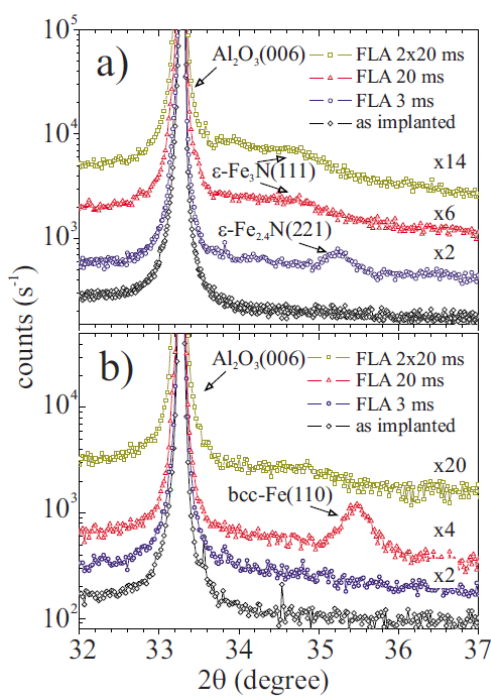
Figure 6. In-situ SXRD (SXRD) observation of the formation of nanoclusters in Fe-implanted p -GaN with a dose of: ( a ) 8 × 10 16 ions/cm 2 , and ( b ) 16 × 10 16 ions/cm 2 . Reproduced with permission from Reference